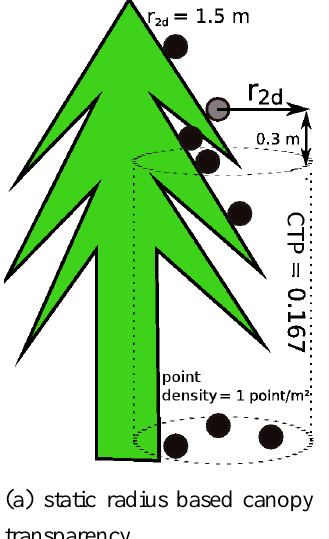
(c) Echo Ratio based canopy